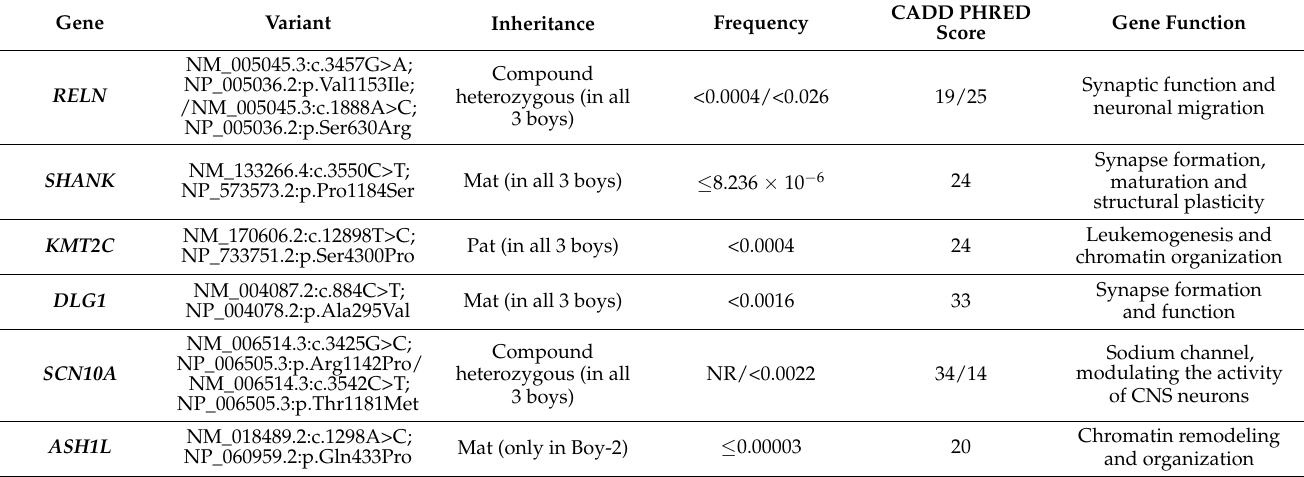
Figure 1. Clinical features and genomic findings distributed in the multiplex family. Table 1. ASD-related genes and variants identified in the multiplex family.